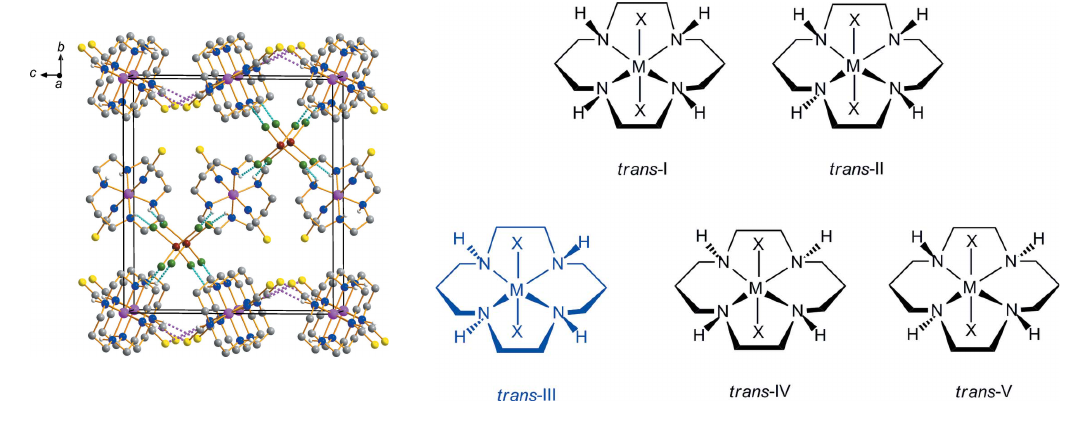
Figure 1 Possible configurations for trans -cyclam complexes with the trans -III configuration adopted by the title compound highlighted in